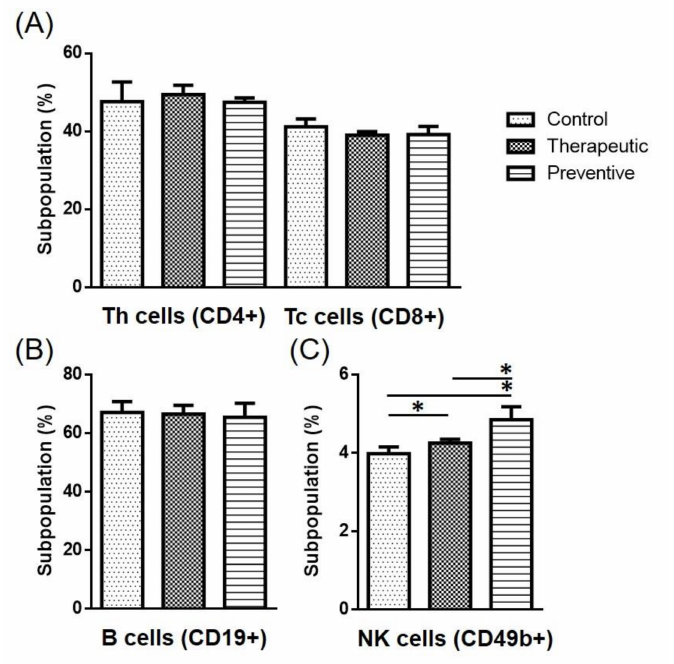
Figure 4. Effects of GF-EPS on the lymphocyte subpopulation in splenocytes of LLC1-tumor bearing mice. Spleen cells were stained with fluorescence-labeled antibody and for flow cytometry. The subpopulations of ( A ) CD4+ and CD8+, ( B ) CD19+, and ( C ) CD49b+ were analyzed. Data are expressed as the mean ± SD. Differences compared with control group with statistical significance at p < 0.05